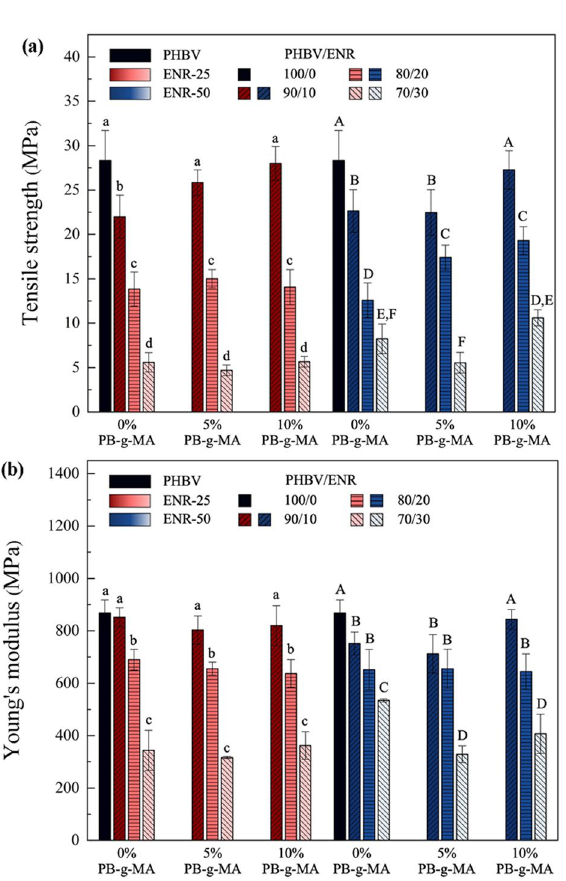
Figure 5. The tensile properties of PHBV/ENR blends ( a ) Tensile strength and ( b ) Young’s modulus. Data are presented as mean ± SD. Groups designated with different letters are significantly different using One-Way ANOVA with Duncan’s multiple range post hoc (at p < 0.05, n =